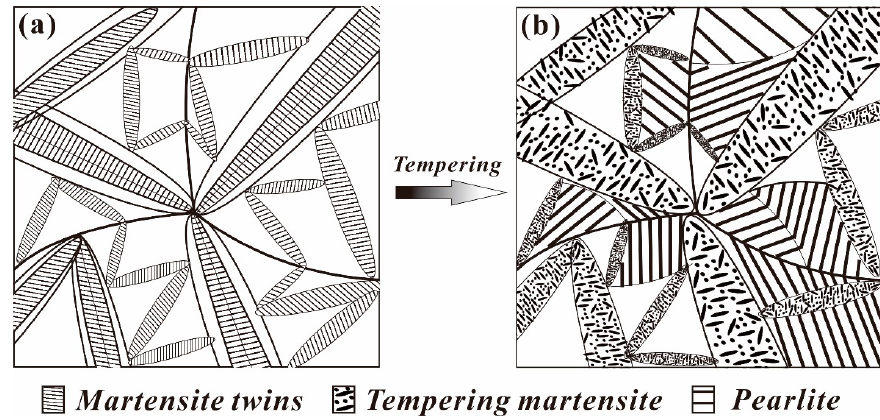
Figure 9. Schematic of the microstructure transformation of quenched martensite into tempered martensite: ( a ) the martensitic structure after quenching and ( b ) the multiphase structure after